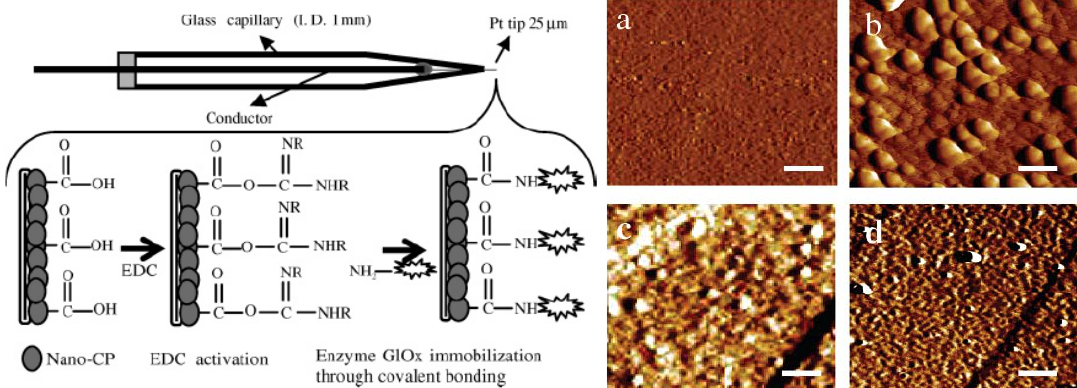
Figure 7. ( Left ) Design of a Pt microelectrode (25 μ m) and schematic representation of the fabrication of a GlOx/nano-CP/Pt microbiosensor. ( Right ) AFM images (scale bar, 750 nm) of (a) a bare HOPG electrode and (b)-(d) nano-CP grown onto the HOPG electrodes through electropolymerization using cyclic voltammetry at a scan rate of (b) 0.1, (c) 0.5, and (d) 1.0 V s -1